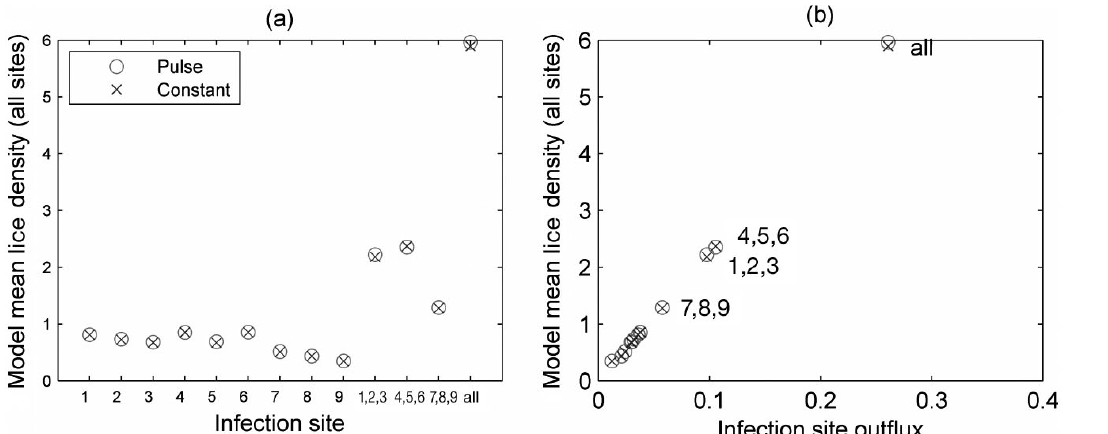
Fig. 5. Mean loch densities. (a) Changing source site. Mean lice density across all 9 sites when particular sites receive external infection. (b) Connectivity outflux versus model mean site density over time. Unlabelled points represent external infection at individual sites, while combinations of sites are labelled. Values for the pulse scenarios (20 d at 0.1 lice fish −1 d −1 ) are deno- ted by ’ O ’, and constant scenarios (0.1 lice fish −1 d −1 throughout) are denoted by ’ O ×